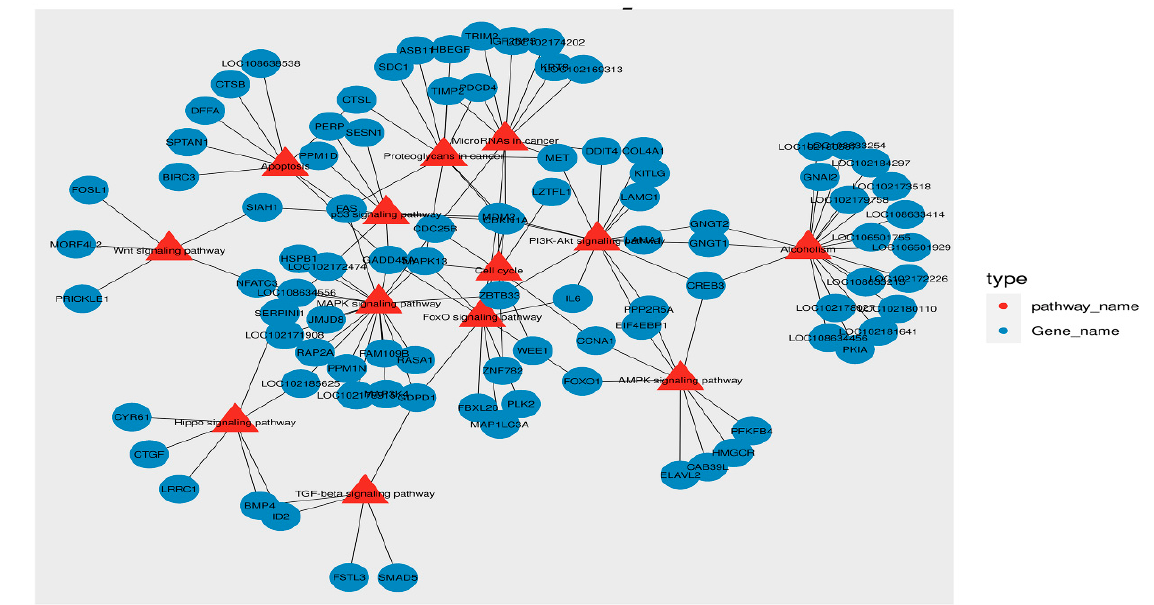
Figure 6. The pathway–gene interaction network diagram was established using ten KEGG pathways and 113 DEGs; the red is the pathway and the green is the gene name.